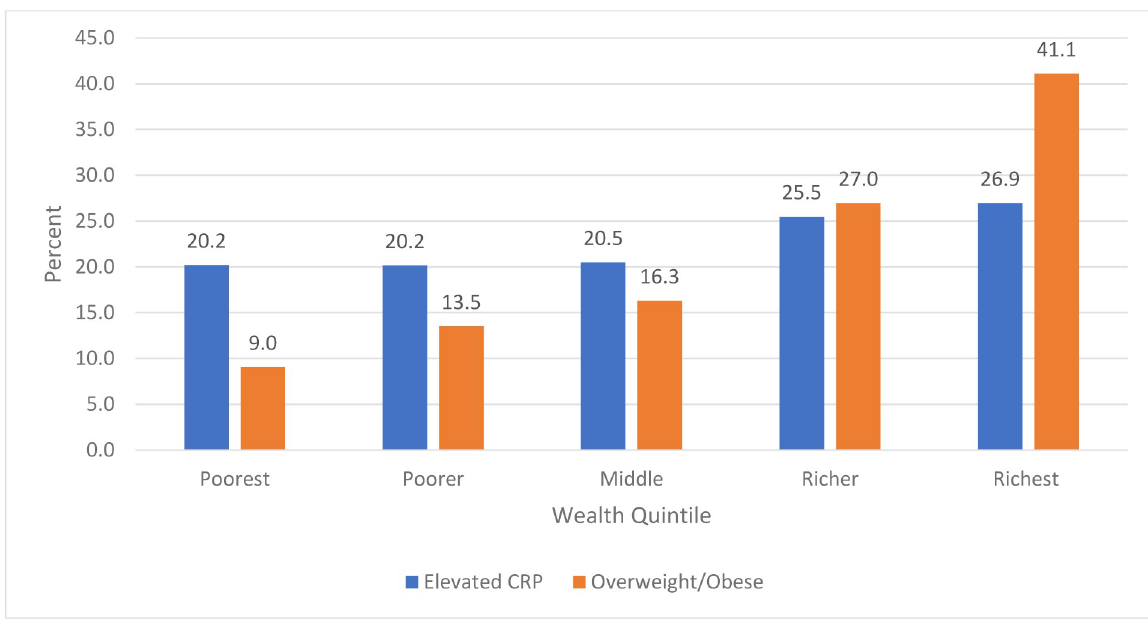
Fig 3. Proportion of participants that have elevated CRP or are overweight/obese by wealth quintiles.